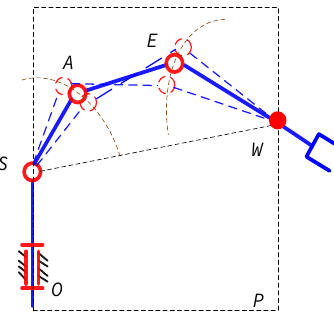
Figure 2. Feature of the self-motion.